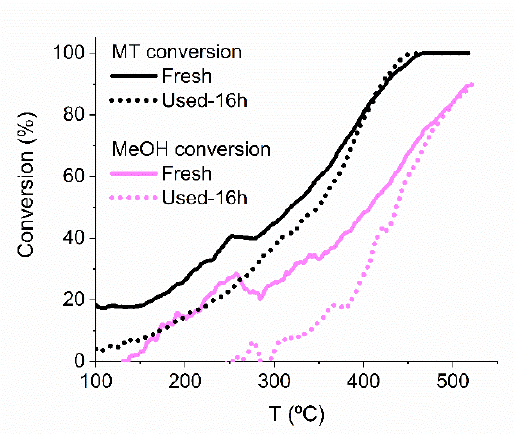
Figure 10. Methanethiol and methanol conversion vs. temperature before (fresh) and after (16 h) the stability test with the CoAlCe-P stability test with the CoAlCe-P catalyst.